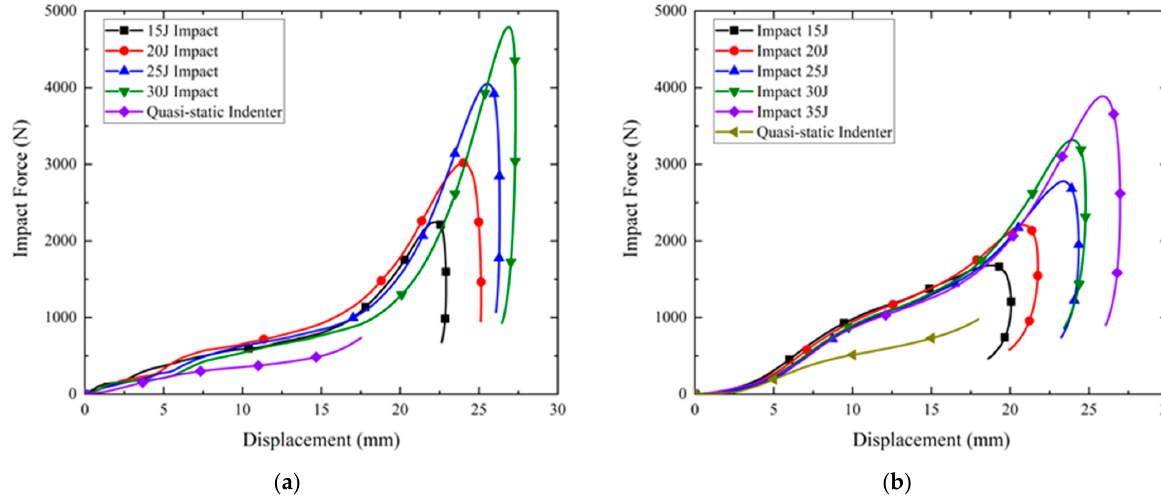
Figure 8. Results of drop hammer tests at rearfoot: ( a ) Gyroid; ( b ) Diamond.